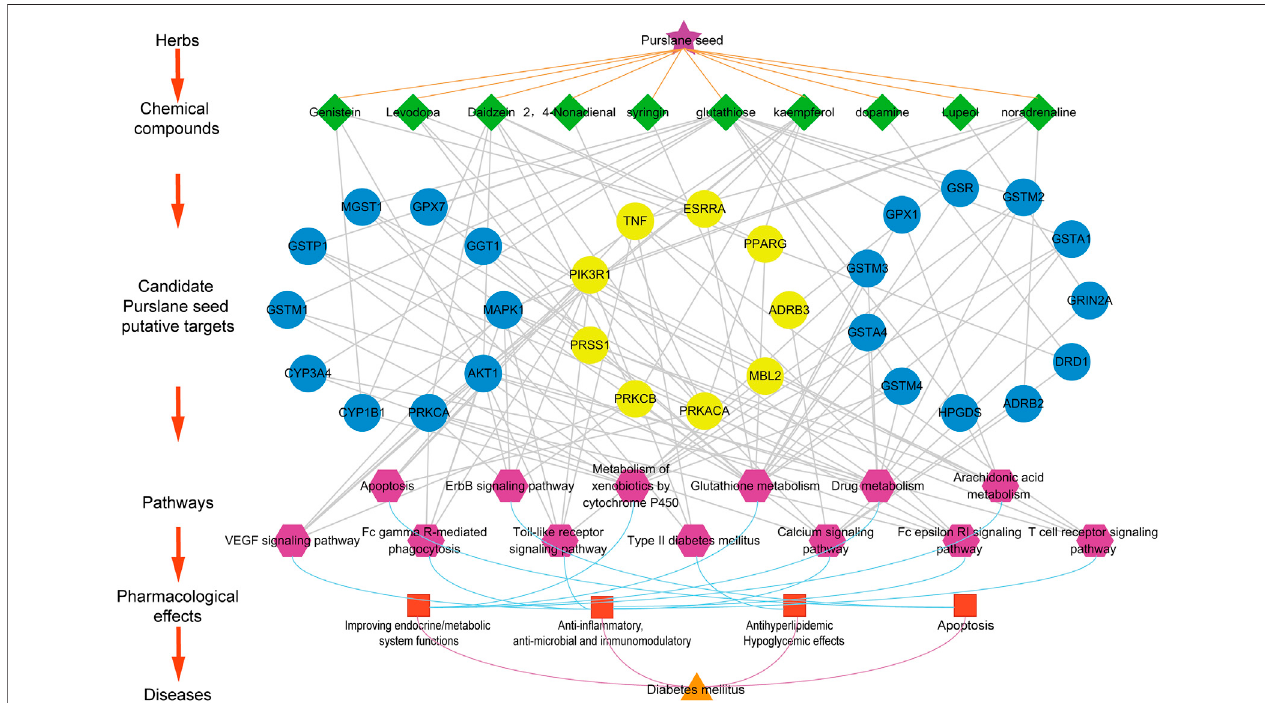
FIGURE8| Thegenesexpressionsof Akt1 (A) , VEGF (B) , ErbB2 (C) and AR (D) inControl,DM,Metand MCXZtreatedgroups. Dataaremean ± SD.* p < 0.05vs. Control; ### p < 0.001, ## p < 0.01, # p < 0.05 vs. the modle group; n (cid:2) 3 animals per group.